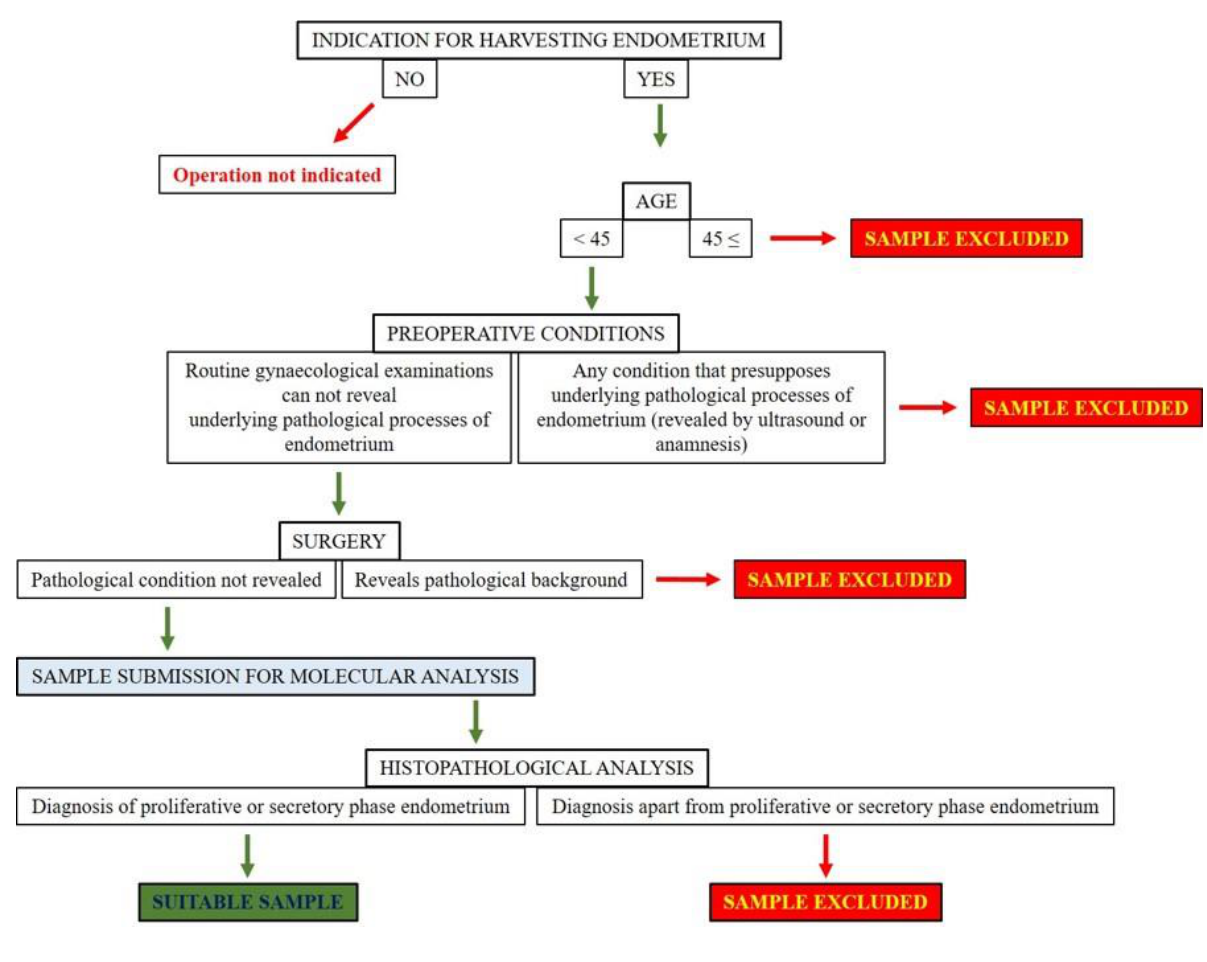
Figure 1. Recommended protocol for the involvement of eutopic endometrium samples to experi- mental research studies.